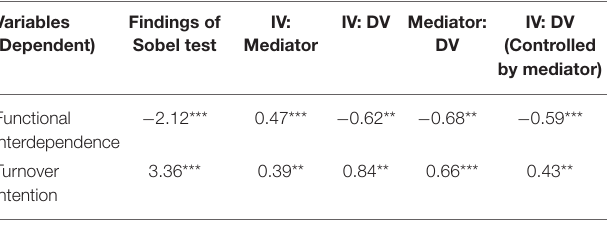
Path values are β ; N = 363; IV, Independent variable (workplace incivility); DV, Dependent variables (Functional interdependence, Turnover intention); * p < 0.05; ** p <